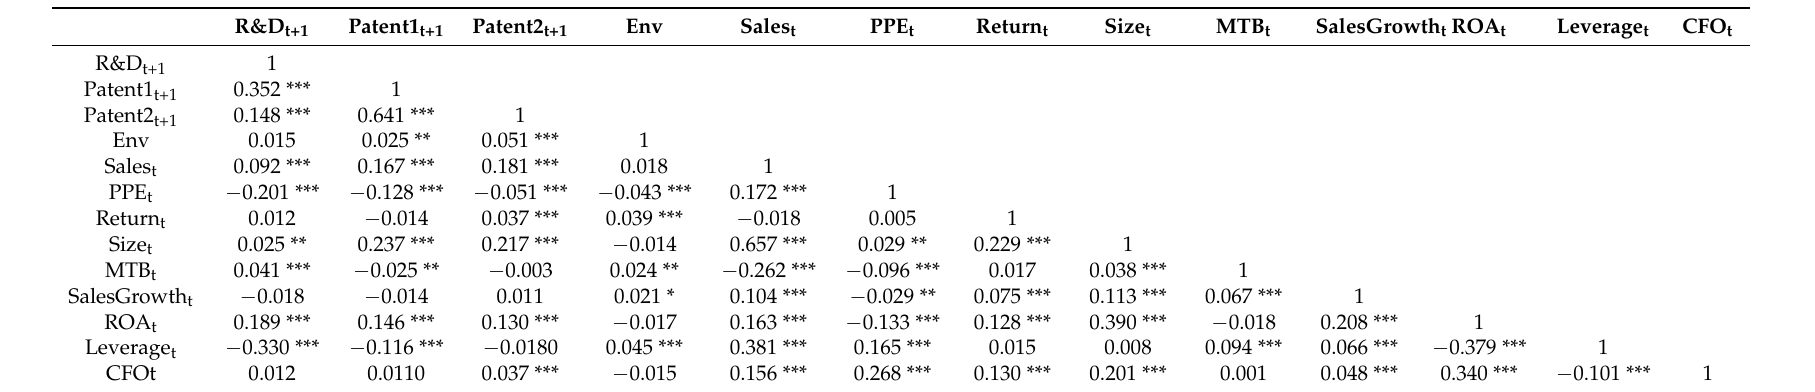
Table 3. Pearson correlation